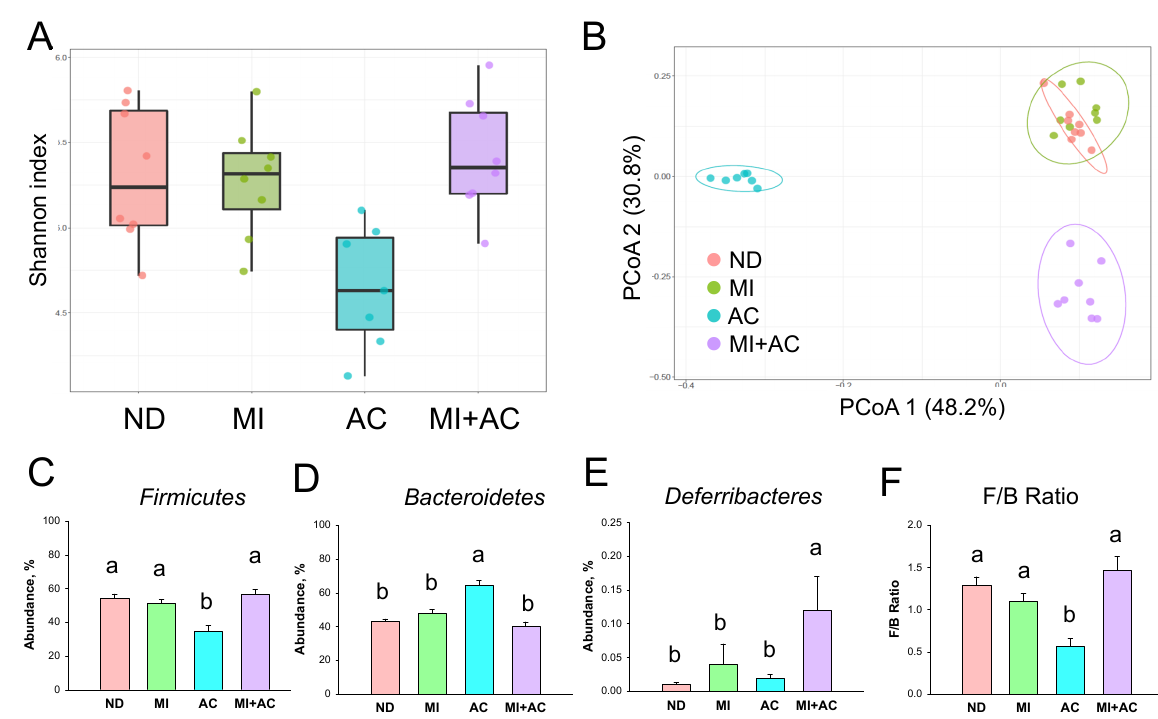
Figure 4. Effect of minocycline administration (MI) and acetate supplementation (AC) on the gut mi- crobiota in 12-week-old male progeny: ( A ) α -diversity using the Shannon index; ( B ) β -diversity using principal coordinate analysis (PCoA); phylum level relative abundance of ( C ) Firmicutes, ( D ) Bac- teroidetes, and ( E ) Deferribacteres; ( F ) the ratio of Firmicutes to Bacteroidetes (F/B) ( n = 7–8/group). The letters a and b above the bars denote significant differences between groups ( p < 0.05, one-way ANOVA). ND = rats received vehicle (control); MI = rats received minocycline; AC = rats received acetate; MI + AC = rats received minocycline and acetate